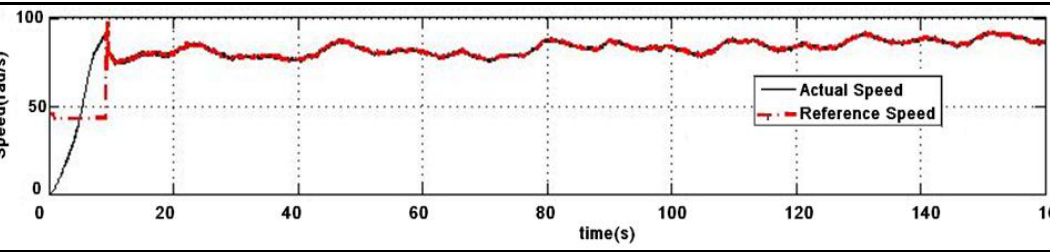
Figure 12. Speed tracking and load voltage under the adaptive SMC system and MPPT control.